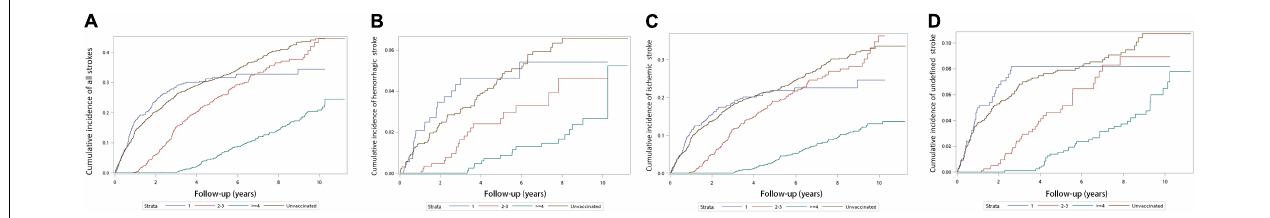
FIGURE 3 | Cumulative incidence rates of different types of strokes estimated by the cumulative incidence function competing risk analysis between patients total number of vaccinations (A) Overall stroke events ( χ 2 = 217.451; df = 3; P < 0.001). (B) Hemorrhagic stroke events ( χ 2 = 27.725; df = 3; P < 0.001). (C) Ischemic stroke events ( χ 2 = 153.256; df = 3; P < 0.001). (D) Undefined stroke events ( χ 2 = 39.481; df = 3; P <